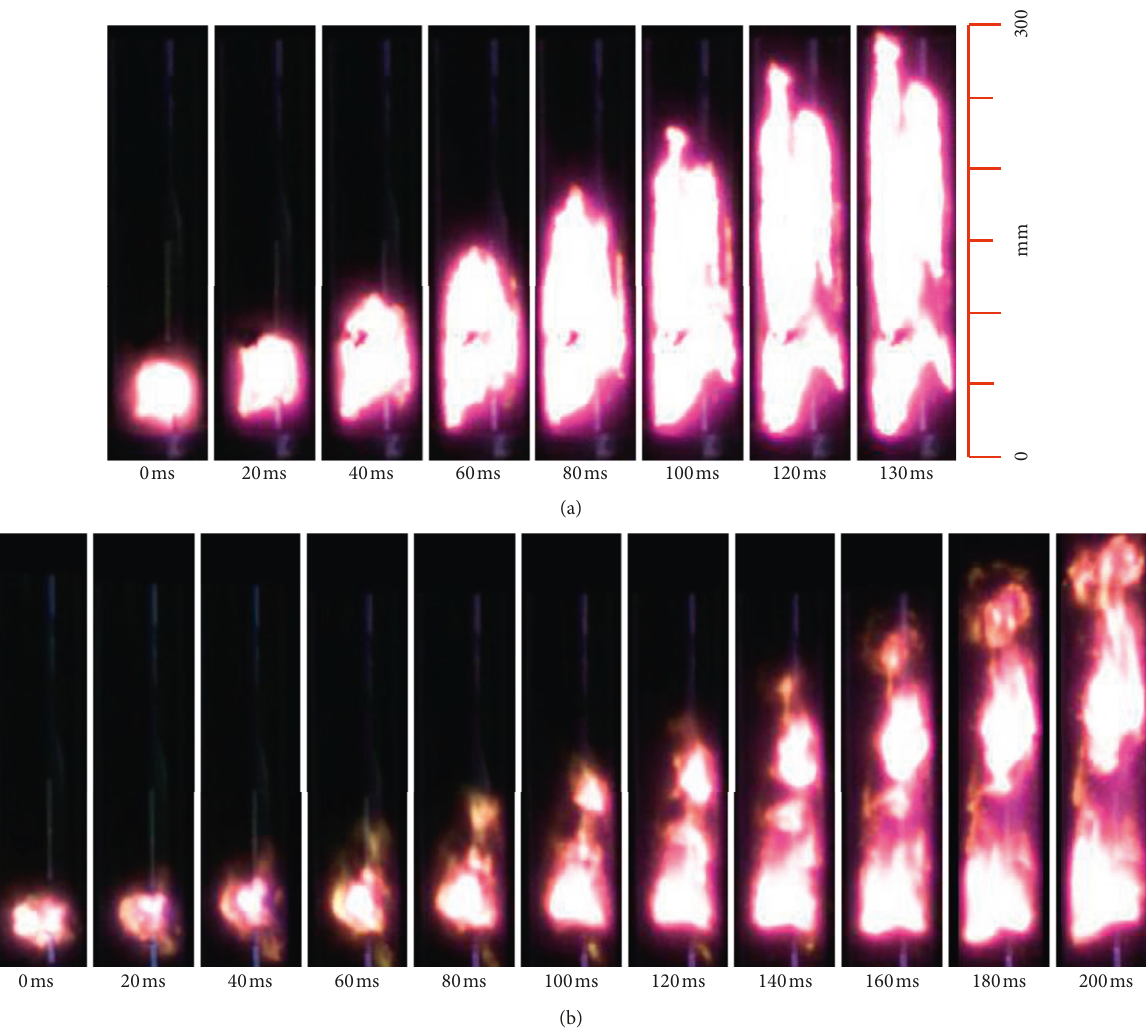
Figure 5: Photographs of the flame propagation: (a) HM; (b)